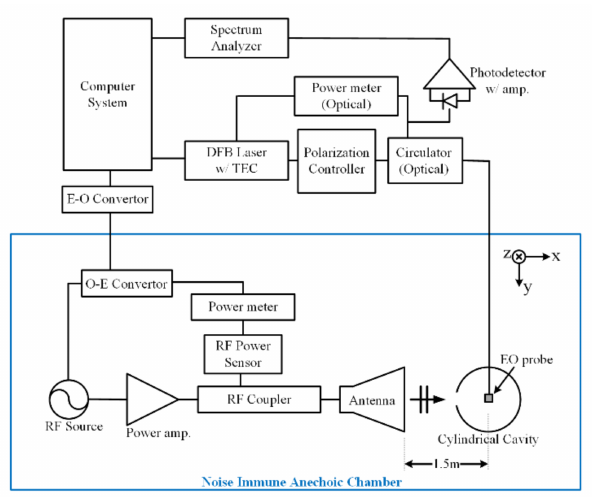
Figure 5. Experimental block diagram of the EO measurement system with a noise immune ane- choic chamber.